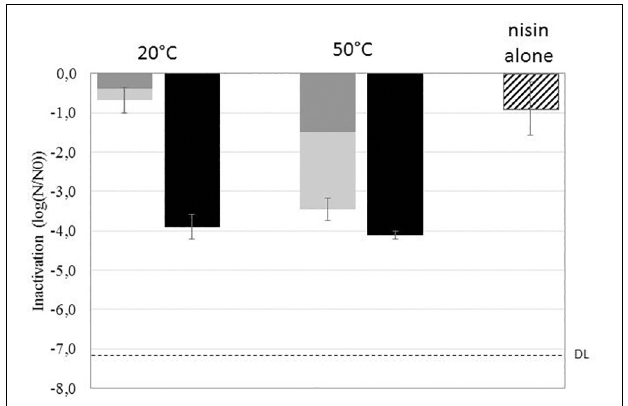
FIGURE 1 | Effect of high pressure (HP) (500 MPa, 10 min, 20 ◦ C or 50 ◦ C) on the inactivation (dark gray), germination (light gray), and sensitization to nisin (black) of Bacillus subtilis PS533 spores. The striped bar represents the effect of nisin alone on spore inactivation. DL, detection limit.